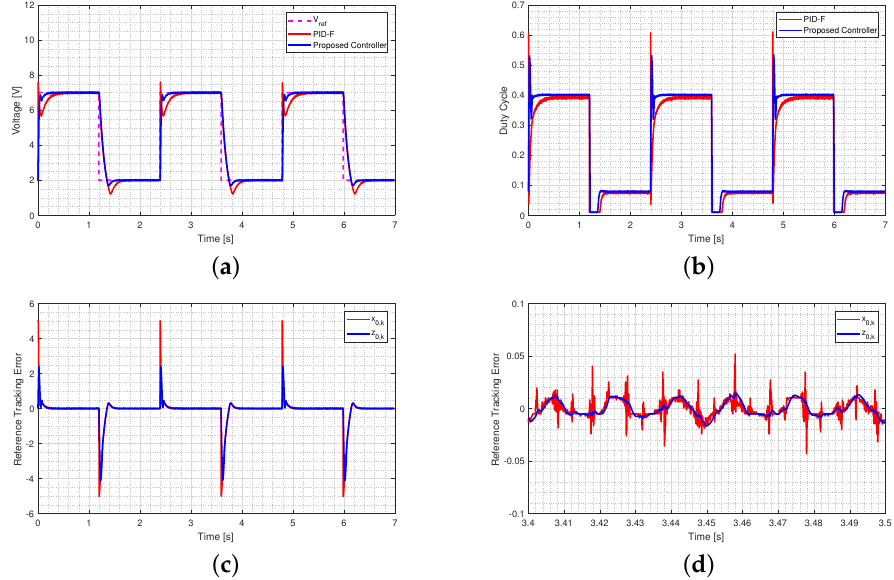
Figure 4. Output voltage tracking performance of the proposed controller and a saturated discrete − time PID with τ = 25 µ s. ( a ) Output voltage and reference; ( b ) control output; ( c ) reference tracking error and its estimation; ( d ) reference tracking error detail.